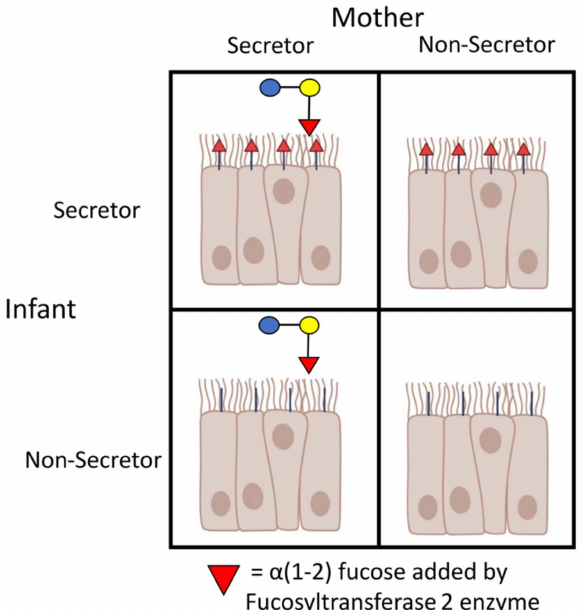
Figure 1. Potential contributions of fucose to the intestinal mucosa of breastfeeding infants by the FUT2 gene product in the infant gut and by a secretor’s